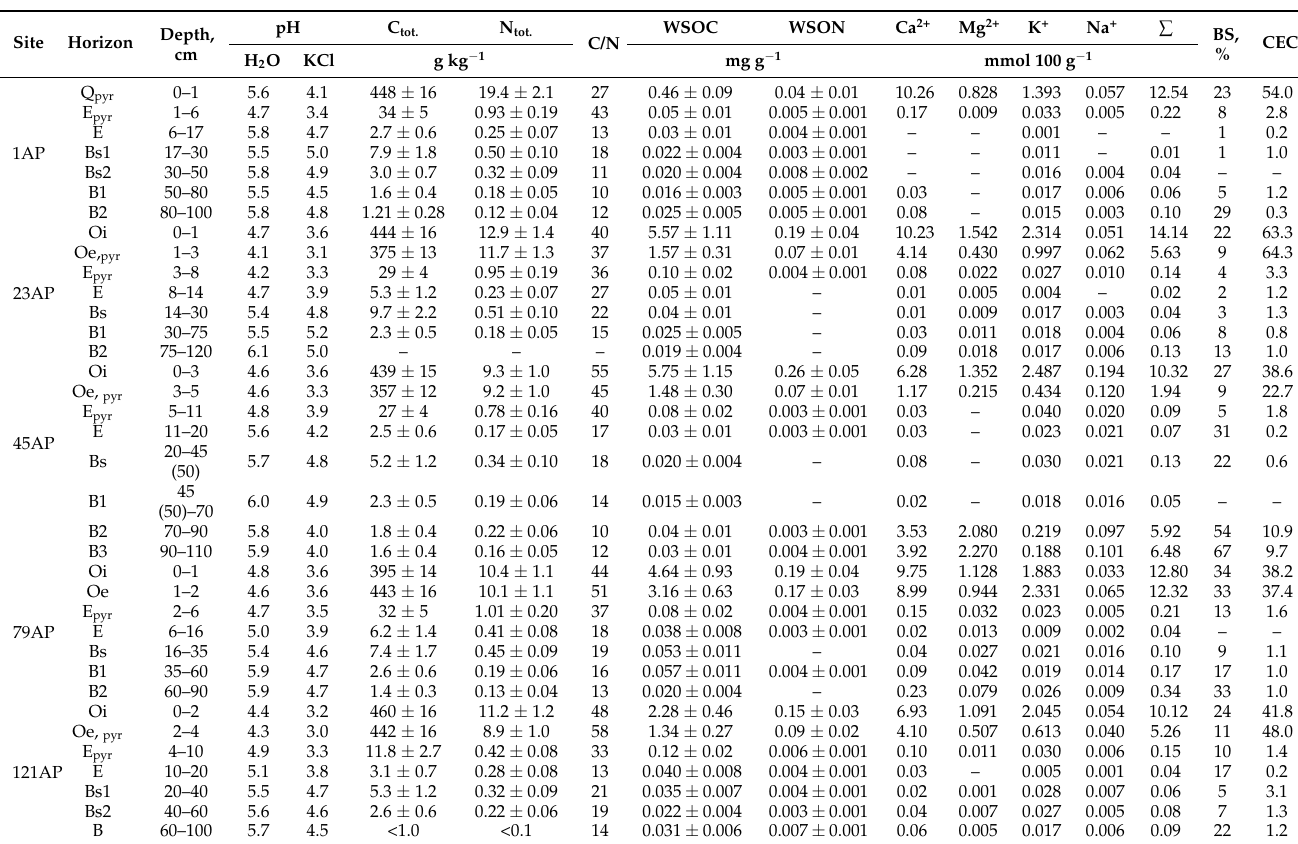
Table 2. Chemical parameters of the studied